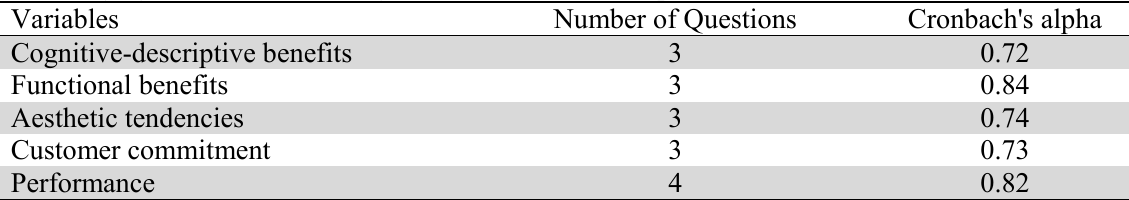
Reliability by Internal Consistency Method (Cronbach's